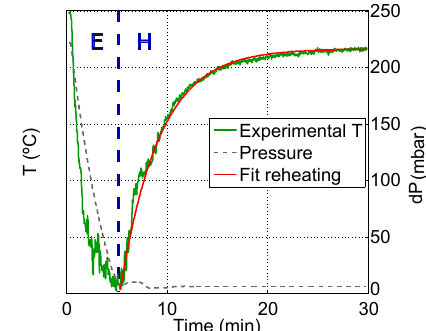
Figure 5. Comparison of the temperature non-uniformity measured by several sensor strings in (a) the radial and (b) the vertical di- rections during calibration runs at 21 and 1 ◦ C, respectively. Linear fits are shown. OS4 and OS5 are not included in panel (b) (see Ap- pendix A for details). The error bars in this and other figures show 1 σ statistical uncertainties and do not account for possible system- atic uncertainties.